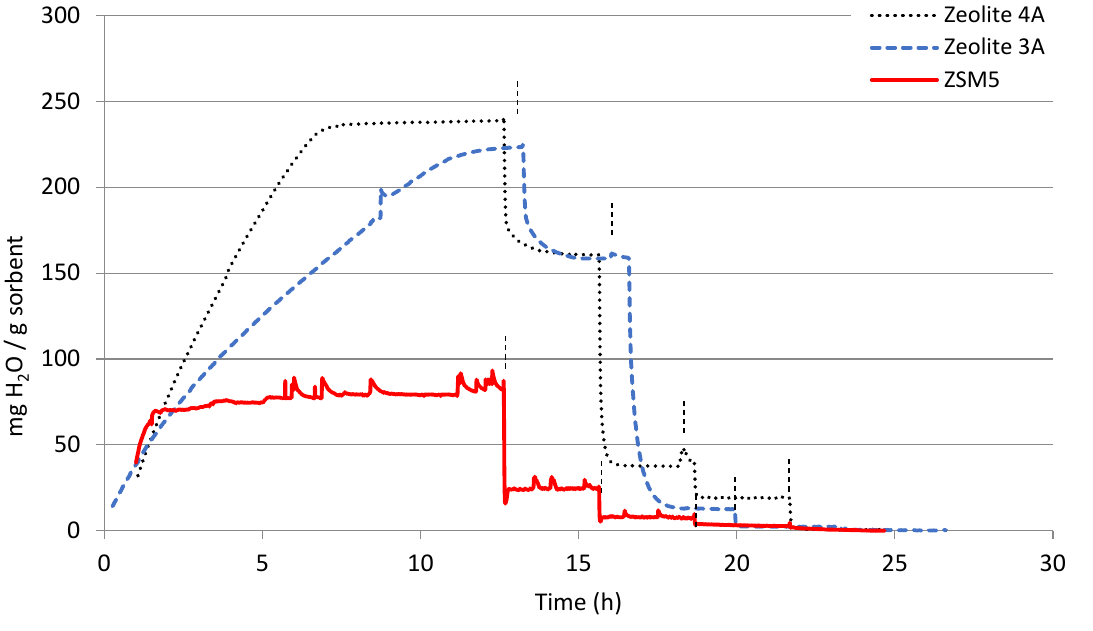
Figure 2. Water sorption capacity of calcined zeolite 4A, zeolite 3A and ZSM5. The vertical lines in each graph indicate the temperature change: 25 °C, 100 °C, 200 °C, 300 °C and 400 °C.